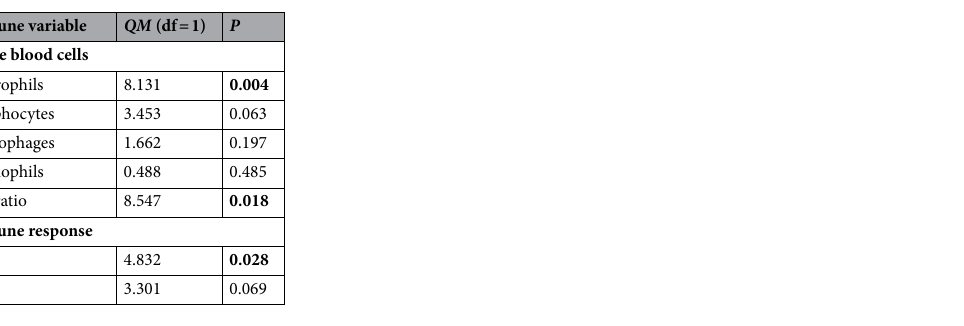
Table 2. Omnibus test of coefficients ( QM ) testing for the effect of season on the sex bias of the immune parameters studied. p values < 0.05 in bold. H/L ratio, heterophils/lymphocytes ratio; PHA, phytohaemagglutinin test; BKA, bacteria-killing ability